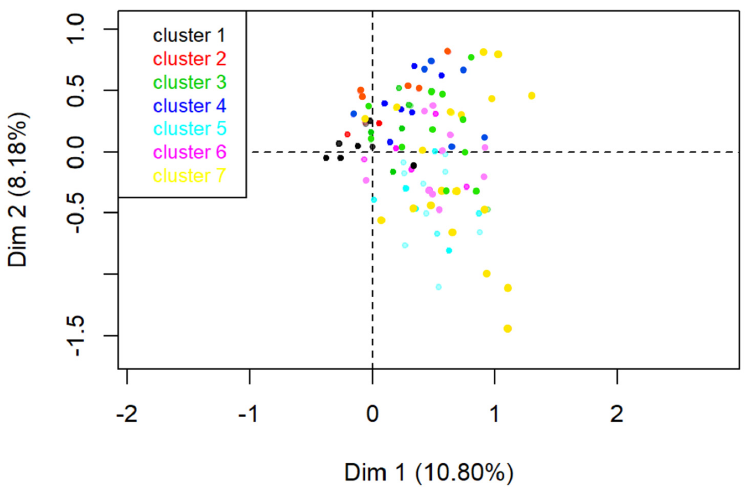
Figure 6. Ascending hierarchical classification of the individuals revealed 7 clusters from the MCA of data extracted from 514 studies captured in a scoping review of the reported causes and syndromes associated with mid to late-term pregnancy loss in horses globally. Table 1. The active and supplementary variables contributing to the formation of the clusters from the MCA of data extracted from 514 studies captured in a scoping review of the reported causes and syndromes associated with mid to late-term pregnancy loss in horses globally.